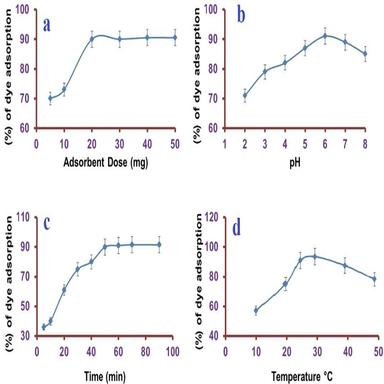
(a) Effect of adsorbent dose on the MO dye adsorption (b) Effect of pH on the MO dye adsorption (c) Effect of time on the MO dye adsorption (d) Effect of temperature on the MO dye adsorption.